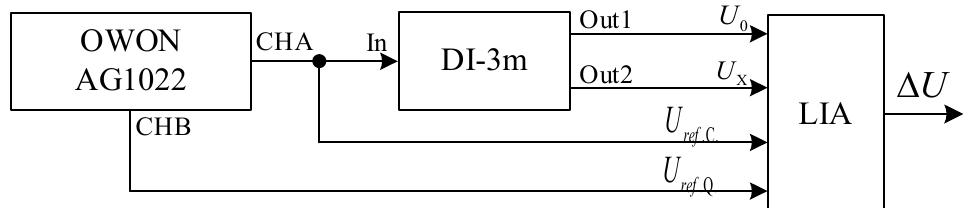
Figure 11. Flowchart of resolution estimation of the lock-in amplifier.